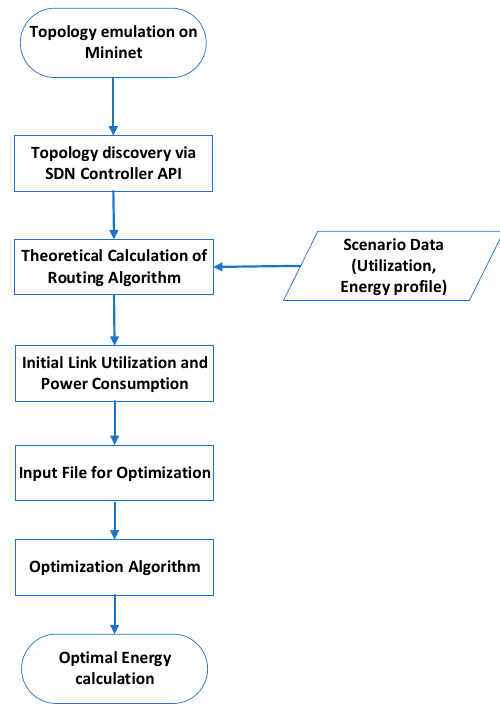
Figure 1. Process followed during the simulation.